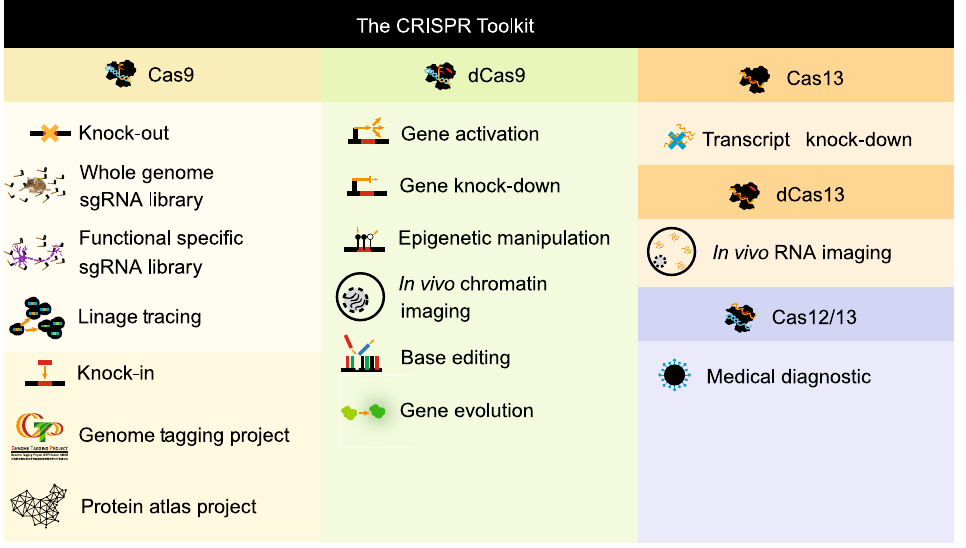
Figure 1. The CRISPR